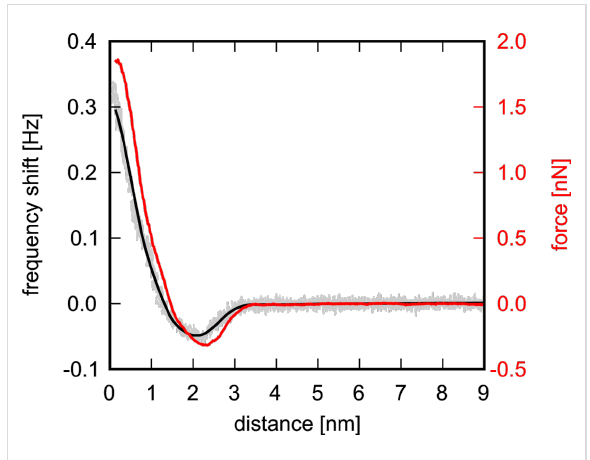
Figure 4: Smoothed frequency-shift (black) versus distance curve on HOPG and tip–sample force F ts (red) calculated from the Sader–Jarvis algorithm. The grey curve corresponds to the frequency shift raw data. A = 1.1 nm.